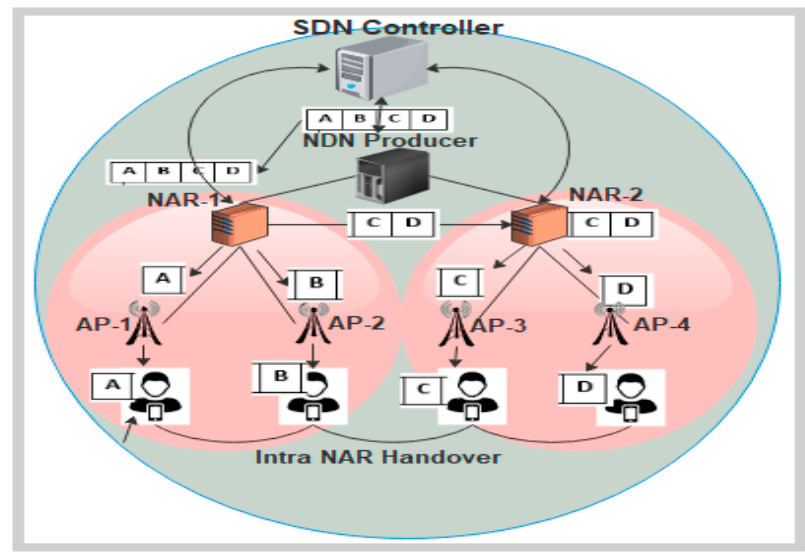
Figure 5. Single SDN controller or intra-domain handover operating scenario.